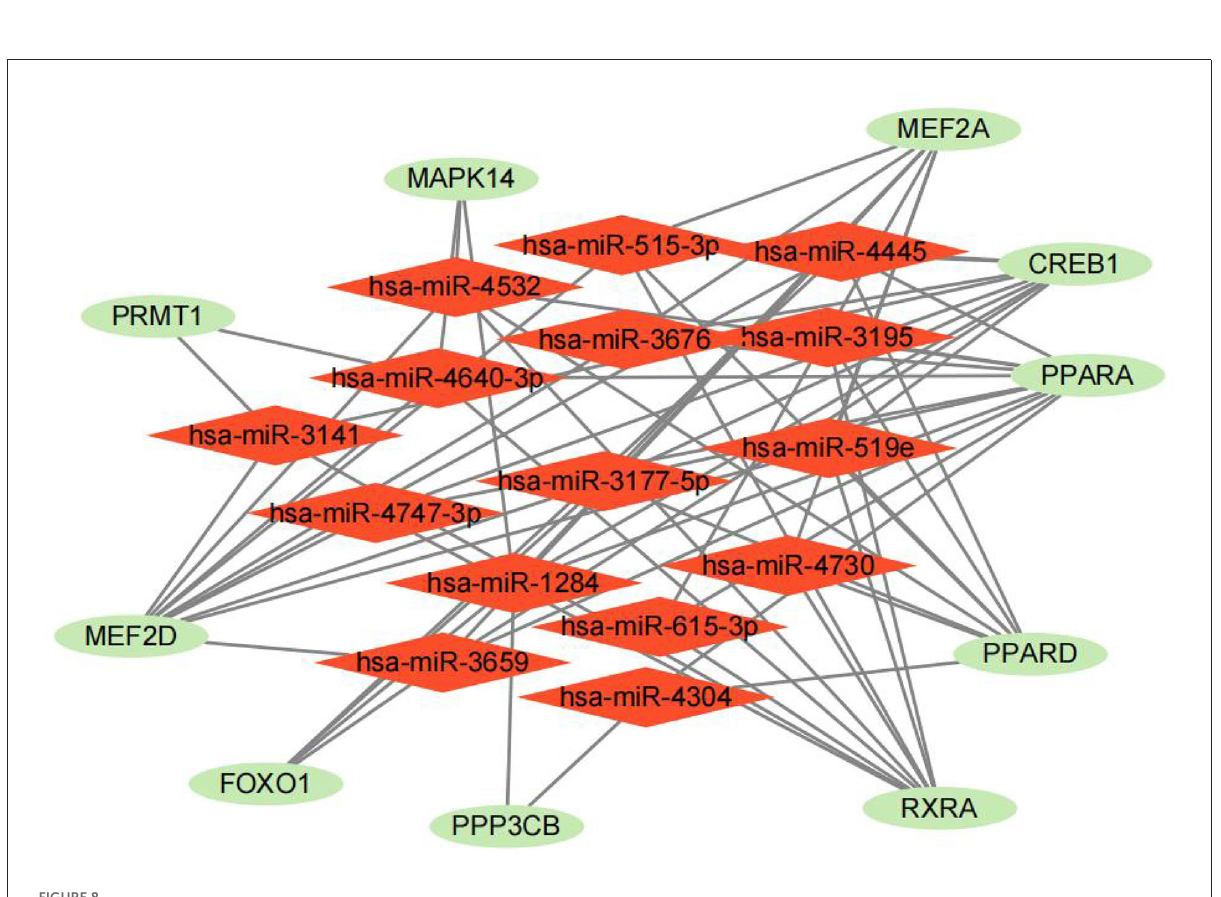
FIGURE8 The prediction of energy metabolism-related